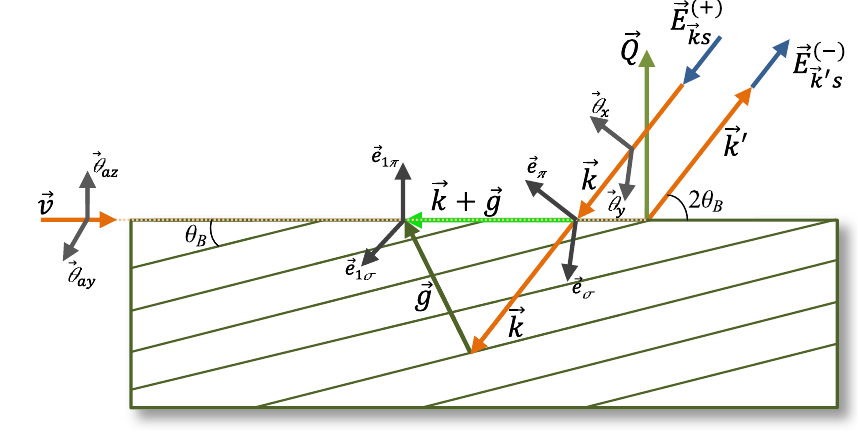
FIG. 4. The geometry for the dynamical diffraction theory of